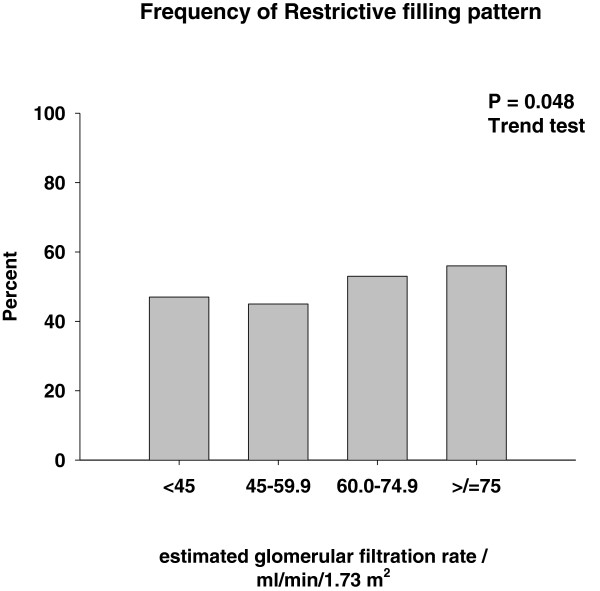
According to groups of estimated glomerular filtration rate (Group I: eGFR < 45 ml/min/1.73 m2, Group II: eGFR 45.0-59.9 ml/min/1.73 m2, Group III: eGFR 60–74.9 ml/min/1.73 m2 and Group IV: eGFR >/= 75.0 ml/min/1.73 m2).*Median and interquartil range.